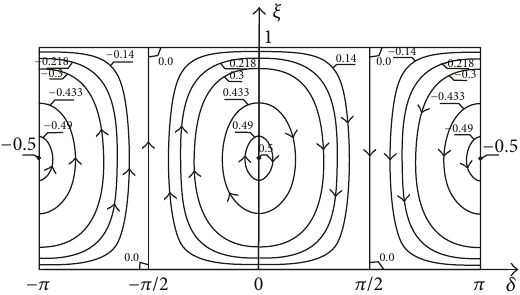
Figure 2: Phase portrait for the case of 1:1 internal resonance 𝜔 1 = 𝐾 = 0 𝜔 2 at